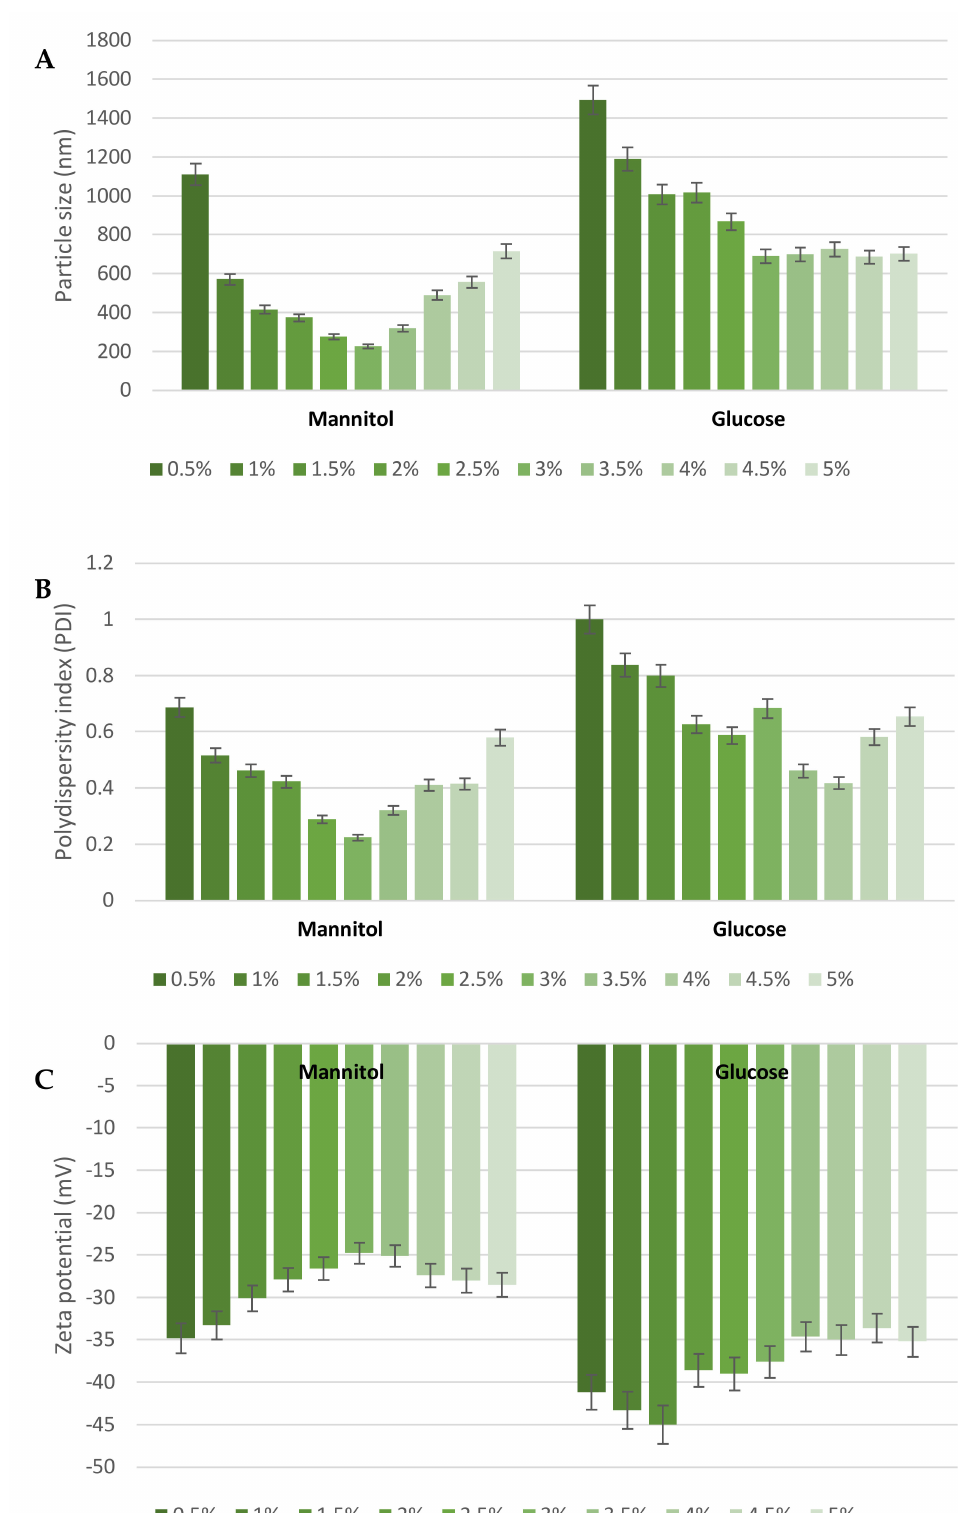
Figure 4. ( A ) Particle size, ( B ) polydispersity index (PDI) and ( C ) Z-potential of MGN–NLC using increasing concentrations of cryoprotectants (mannitol and